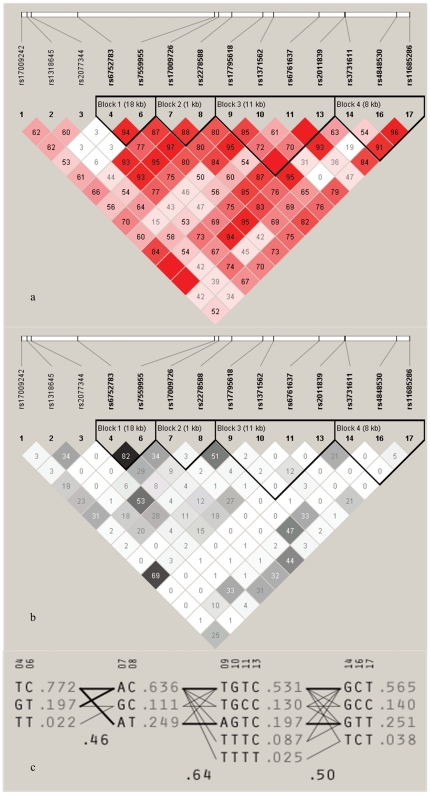
Linkage disequilibrium (LD) map of SNPs.(a) LD map based on D-prime (D’); (b) LD map based on R-squared (R2); (c) haplotypes of SNPs in the “blocks”.